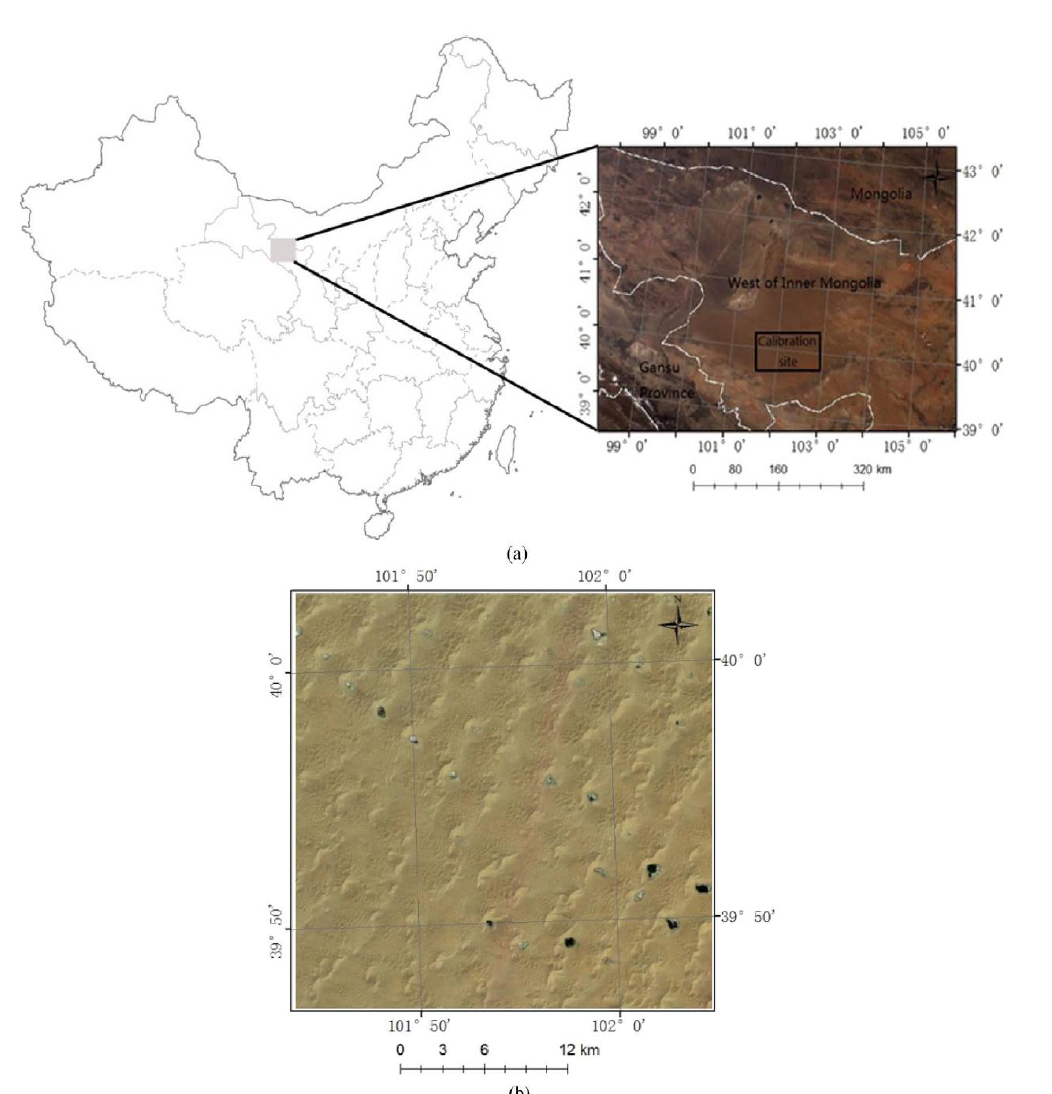
Figure 1. Location and close view of the calibration site. ( a ) Location of the calibration site and a true colour composite from MODIS imagery. ( b ) Close view of the site from a true colour composite of Landsat-7/ETM+